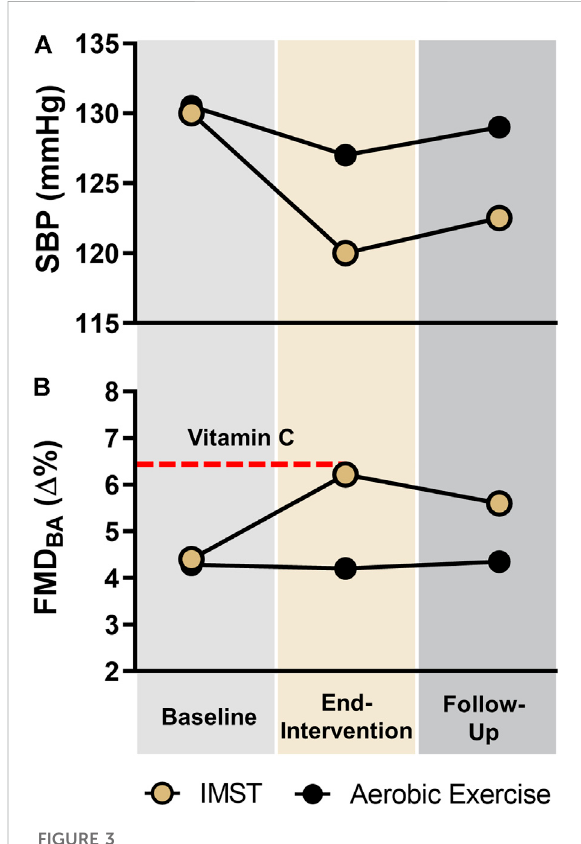
FIGURE 3 Expected Results. Expected results for (A) casual systolic blood pressure (SBP; primary outcome) and 24-h SBP (secondary outcome); and for (B) endothelial function measured by brachial artery fl ow-mediated dilation (FMD BA ; secondary outcome) in the high-resistance inspiratory muscle strength training (IMST) and moderate-intensity aerobic exercise groups across the intervention. Dashed line represents expected FMD BA with supratherapeutic infusion of the potent antioxidant, vitamin C, in both subject